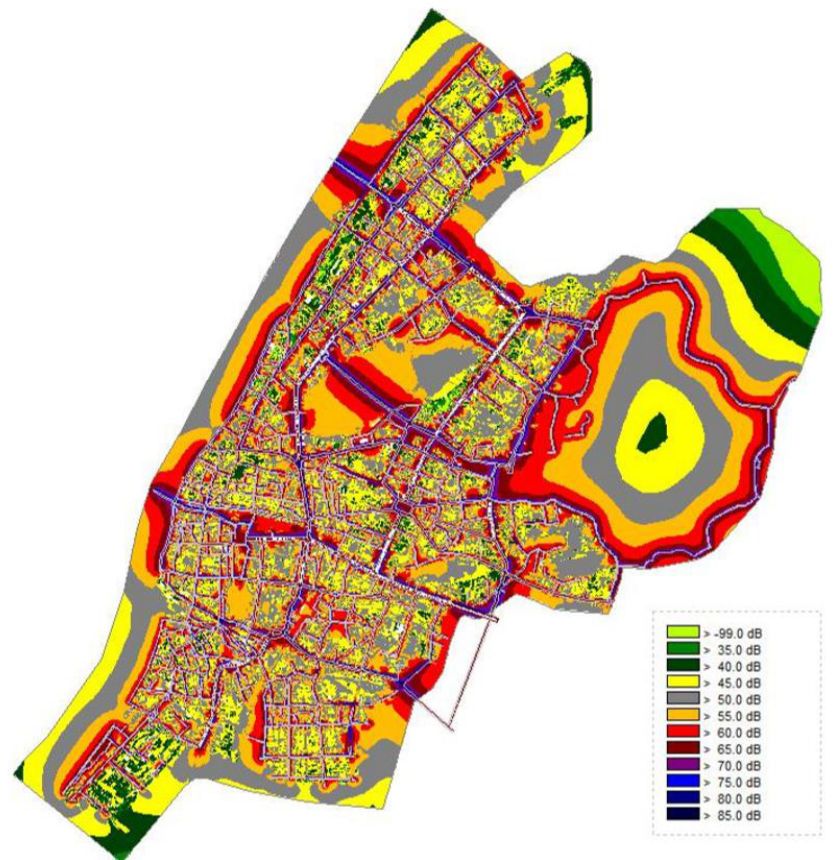
Figure 3. Noise simulation results.